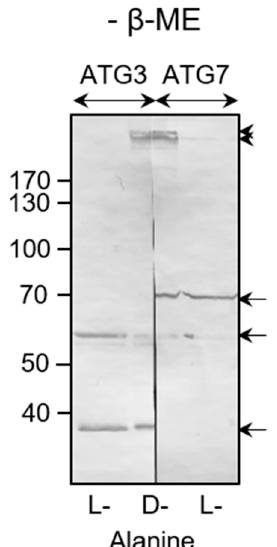
Figure 11. Peroxisome-derived H 2 O 2 triggers complex formation between ATG3 and ATG7. DD- DAO Flp-In T-REx 293 cells were cultured as described in the legend to Figure 3. Next, the cells were incubated in DBPS containing 10 mM 3-amino-1,2,4-triazole and 10 mM L- or D-Ala. After 60 min, the free thiol groups were blocked with N-ethylmaleimide. Thereafter, the cells were processed for non-reducing SDS-PAGE and subsequently subjected to immunoblot analysis with antibodies specific for ATG3 or ATG7. Note that before probing the blots, the D-Ala lane was cut in two to unambiguously identify ATG3/ATG7-containing complexes. The migration points of relevant molecular mass markers (expressed in kDa) are shown on the left. The arrows and arrowheads mark non-oxidatively and oxidatively modified immunoreactive protein bands, respectively.